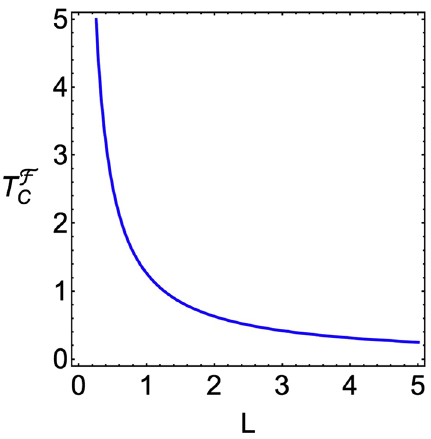
Fig. 6 T F c as a function of the distance between plates L